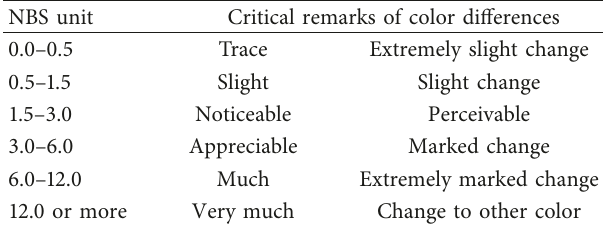
Table 2: National Bureau of Standards (NBS) ratings.